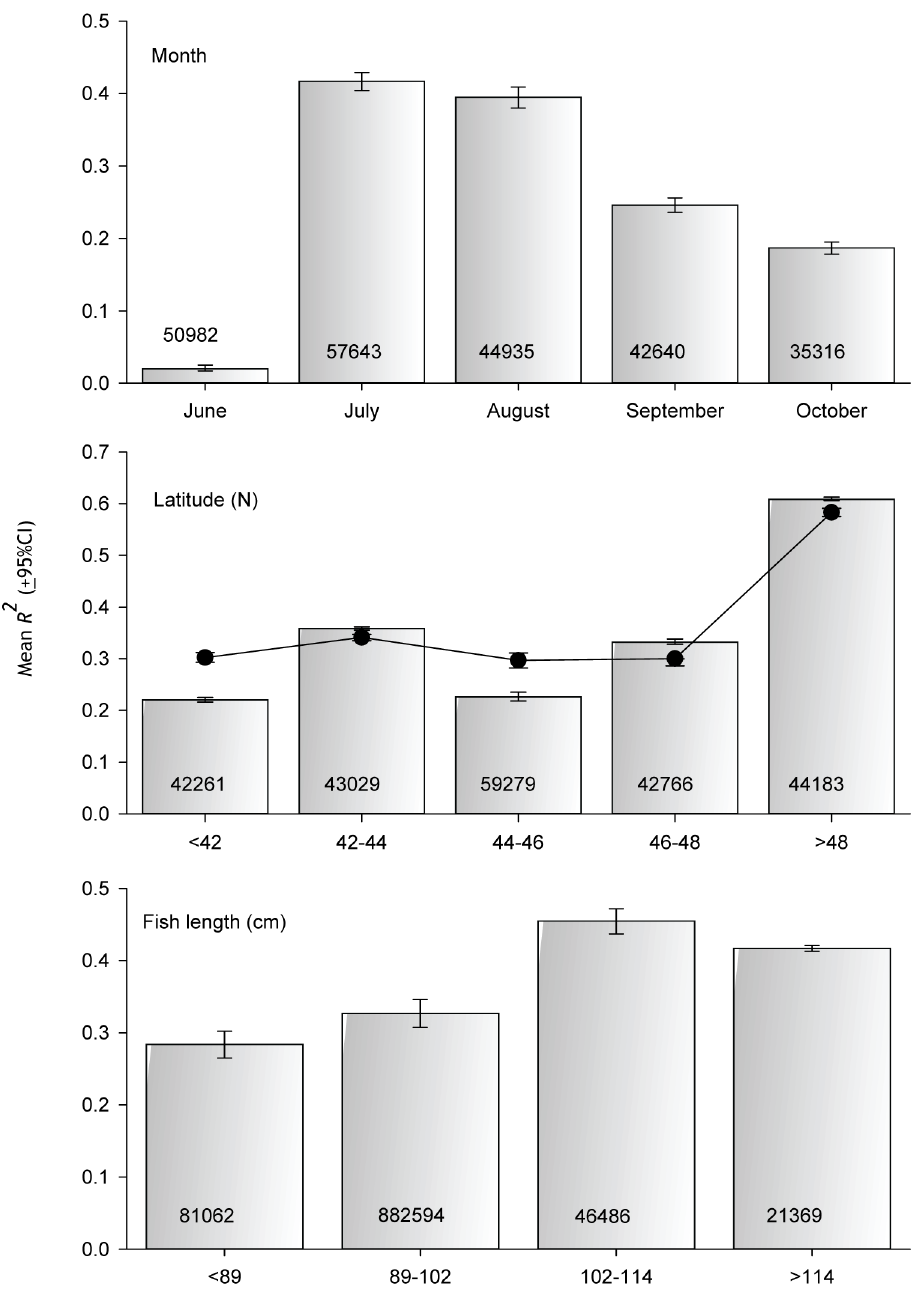
Figure 6. Factors influencing the strength of the relationship between the lunar cycle and number of fish caught. Mean R 2 values are for 100 model runs of 30,000 (latitude and month) or 20,000 (length) randomly selected daytime caught fish. All models are of the form y=a + xcosine2 h , where y = number of fish caught and h is the angular equivalent of lunar day. Value inside bars is N. Scatter plot for Latitude is the mean R 2 when June and October are excluded from regression models.